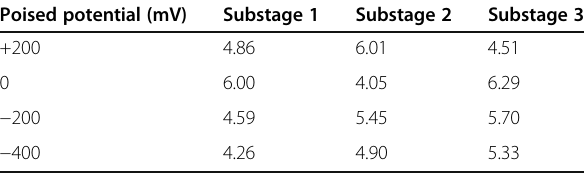
Table 3 Shannon ’ s diversity index at four poised potentials Poised potential (mV) Substage 1